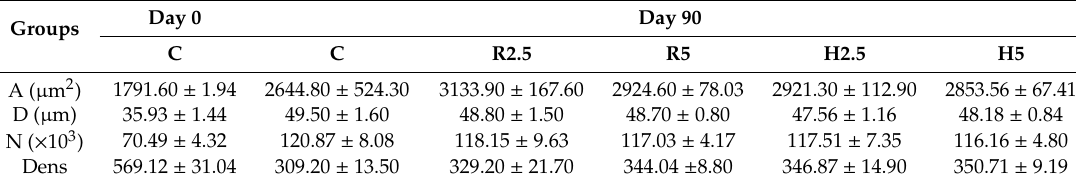
Table 10. Mean values of the muscle cellularity of all groups at day 0 (beginning of the experiment) and 90 (end of the feeding